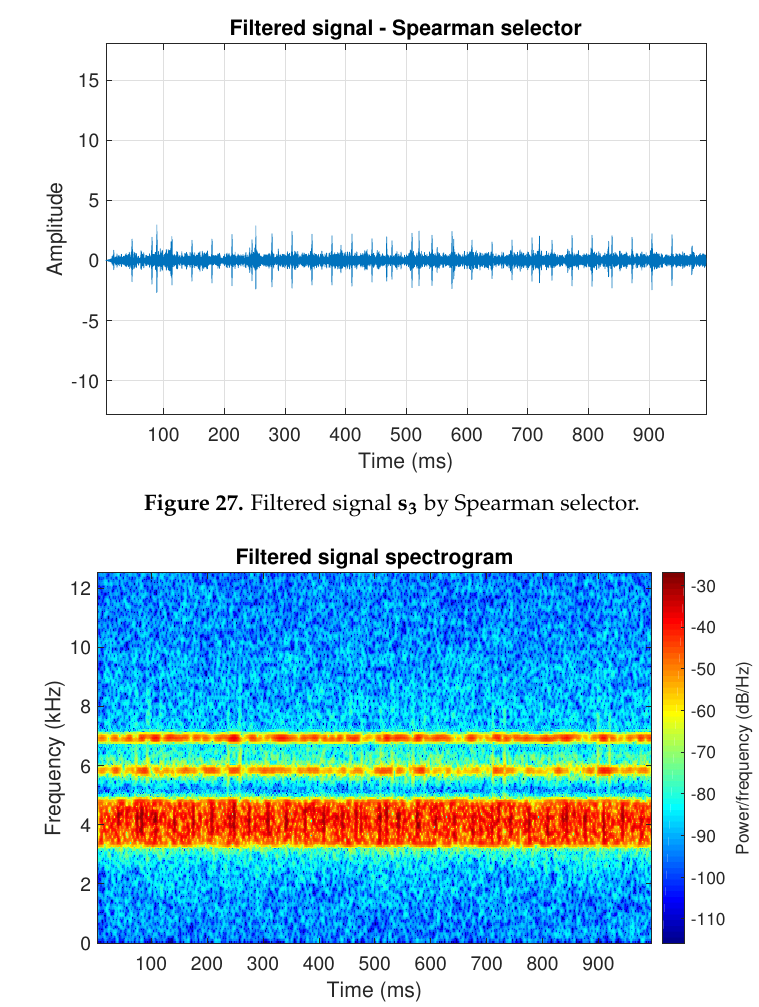
Figure 28. Spectrogram of filtered signal s 3 by Spearman